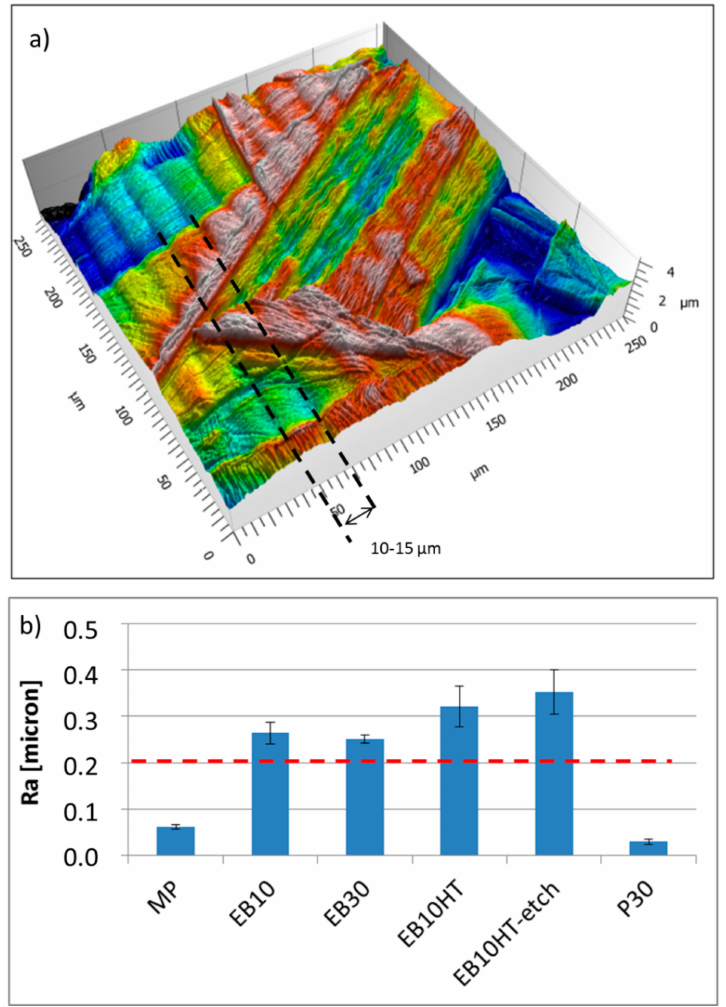
Figure 2. ( a ) Confocal microscopy 3D image of EB10 sample, ( b ) roughness measurements (contact